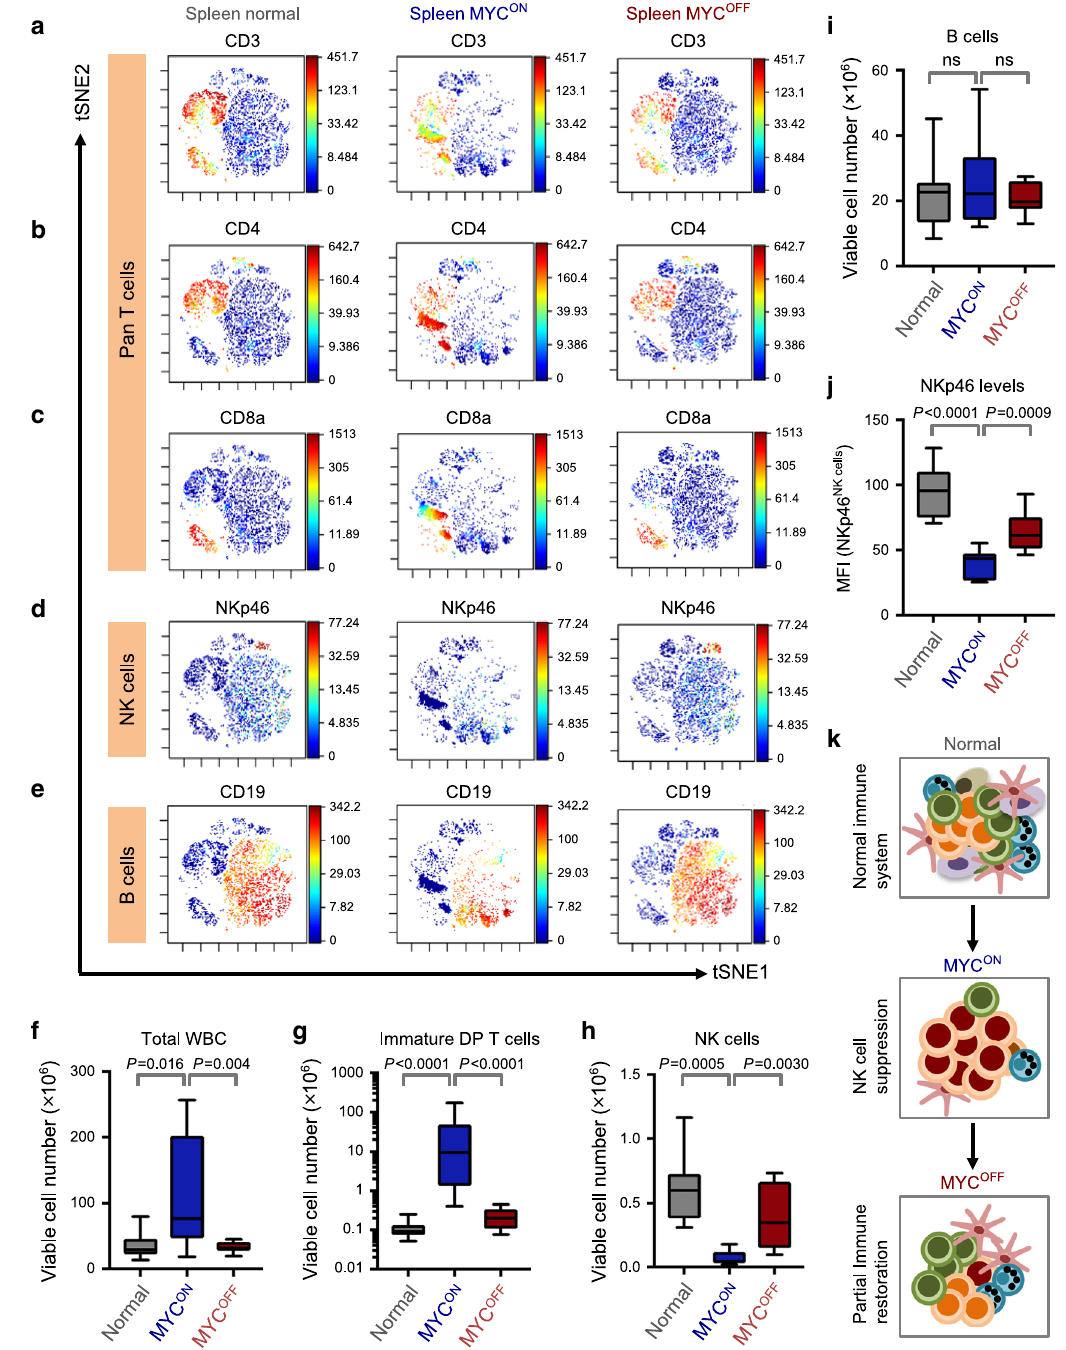
Fig. 1 NK cells are reduced in numbers and maturation in MYC-driven T-lymphomas. a – e viSNE of CyTOF data depicting splenic CD3 + T ( a ), splenic CD4 + T ( b ), CD8a + T ( c ), NKp46 + NK ( d ) and CD19 + B ( e ) cell compositions of one representative mouse from normal ( n = 11), SR α -tTA MYC ON ( n = 9) and SR α -tTA MYC OFF (doxycycline 96 h, n = 10) groups. f – i Quanti fi cation of absolute counts of total WBC ( f ), immature CD3 + CD8 + CD4 + DP lymphoma T cells ( g ), CD3 − NKp46 + mature NK ( h ) and CD19 + B ( i ) cells in normal ( n = 11), SR α -tTA MYC ON ( n = 9) and SR α -tTA MYC OFF (doxycycline 96 h, n = 10) mice subjected to CyTOF. j Median fl uorescence intensity (MFI) of NKp46 on splenic NK cells from normal ( n = 11), SR α -tTA MYC ON ( n = 9) and SR α -tTA MYC OFF (doxycycline 96 h, n = 10) mice. k Schematic depicting the reversible phenomenon of NK cell (blue) suppression in MYC-driven lymphomas (red). p -values have been calculated using a two-sided Mann – Whitney test. ns not signi fi cant. For all box plots, the center is at the median, minima and maxima are indicated by whiskers, and the box represents data between the 25th and 75th